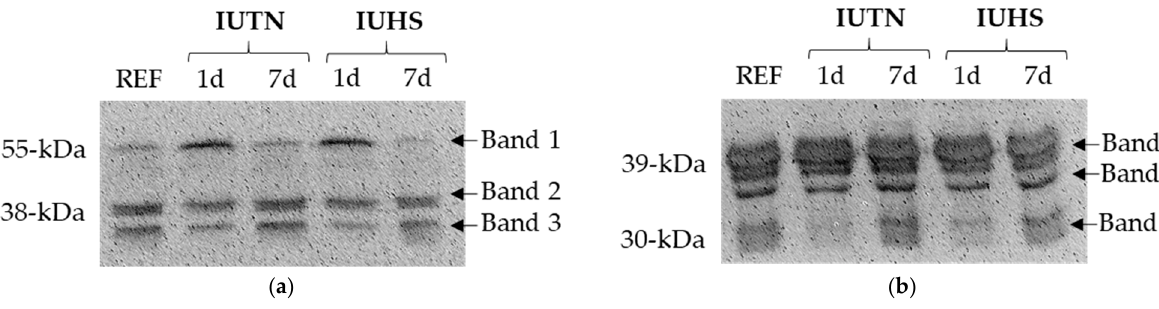
Figure 2. Representative Western blots of desmin ( a ) and troponin T ( b ) from in utero heat stress (IUHS) and in utero thermoneutral (IUTN) treatments at 1 d and 7 d postmortem. REF was same IUTN sample at 7 d postmortem.